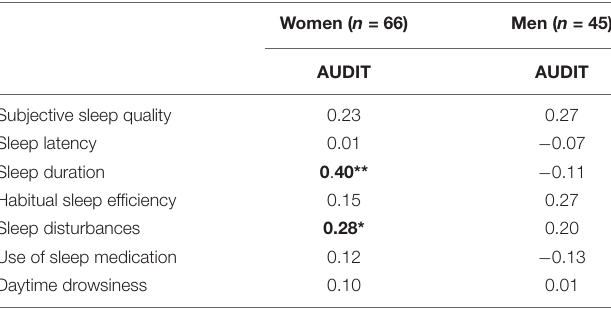
scores in men and